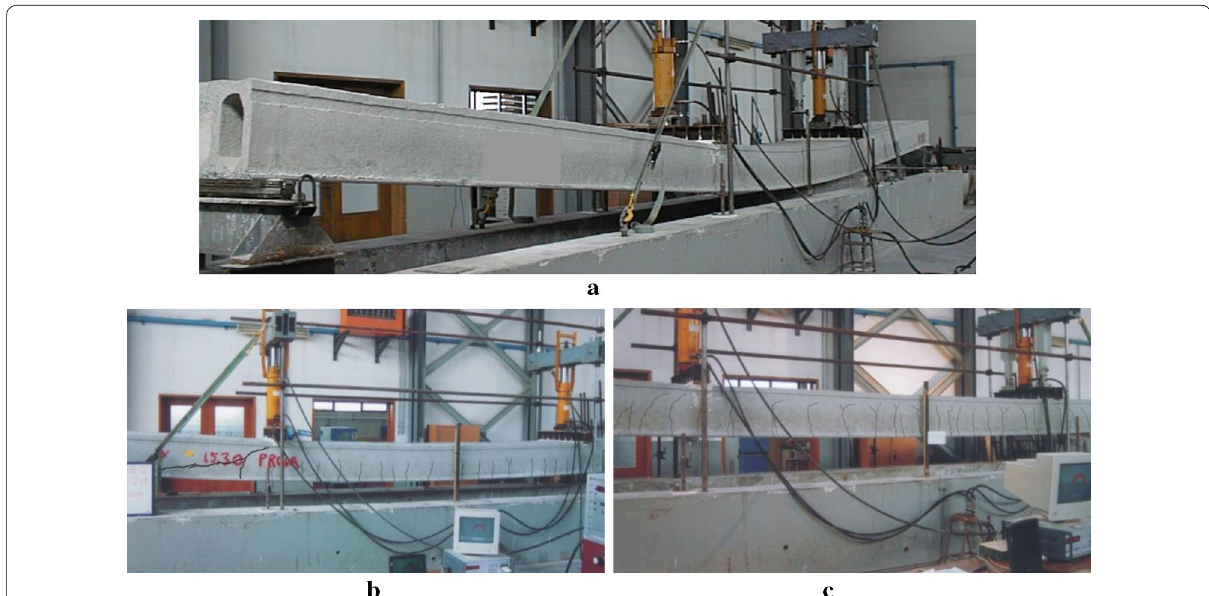
Fig. 5 Flexural tests: a specimen deflections at the end of the test; b , c experimental crack pattern in correspondence of the maximum applied load for slab H50-f1 and slab H50-f2,